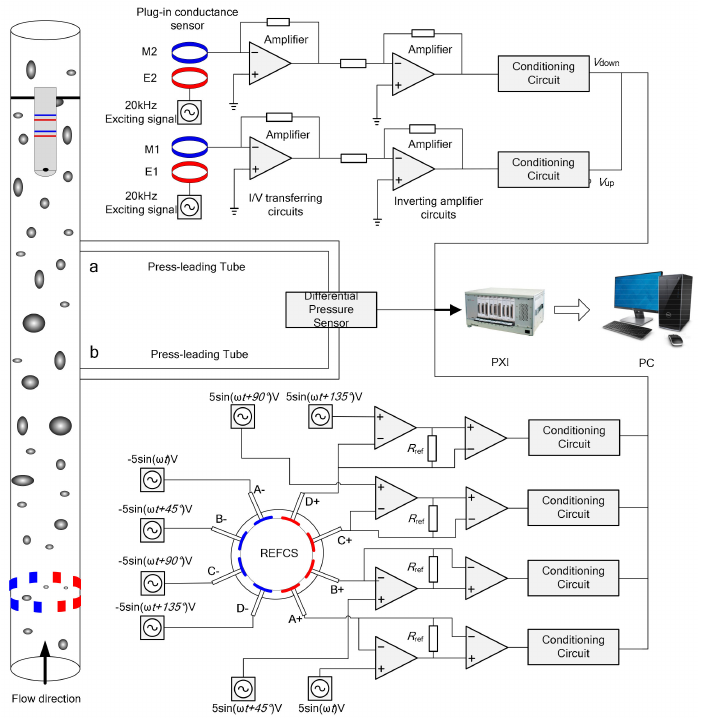
Figure 1. Measurement system of plug-in conductance sensor, di ff erential pressure sensor and rotating electric field conductance sensor